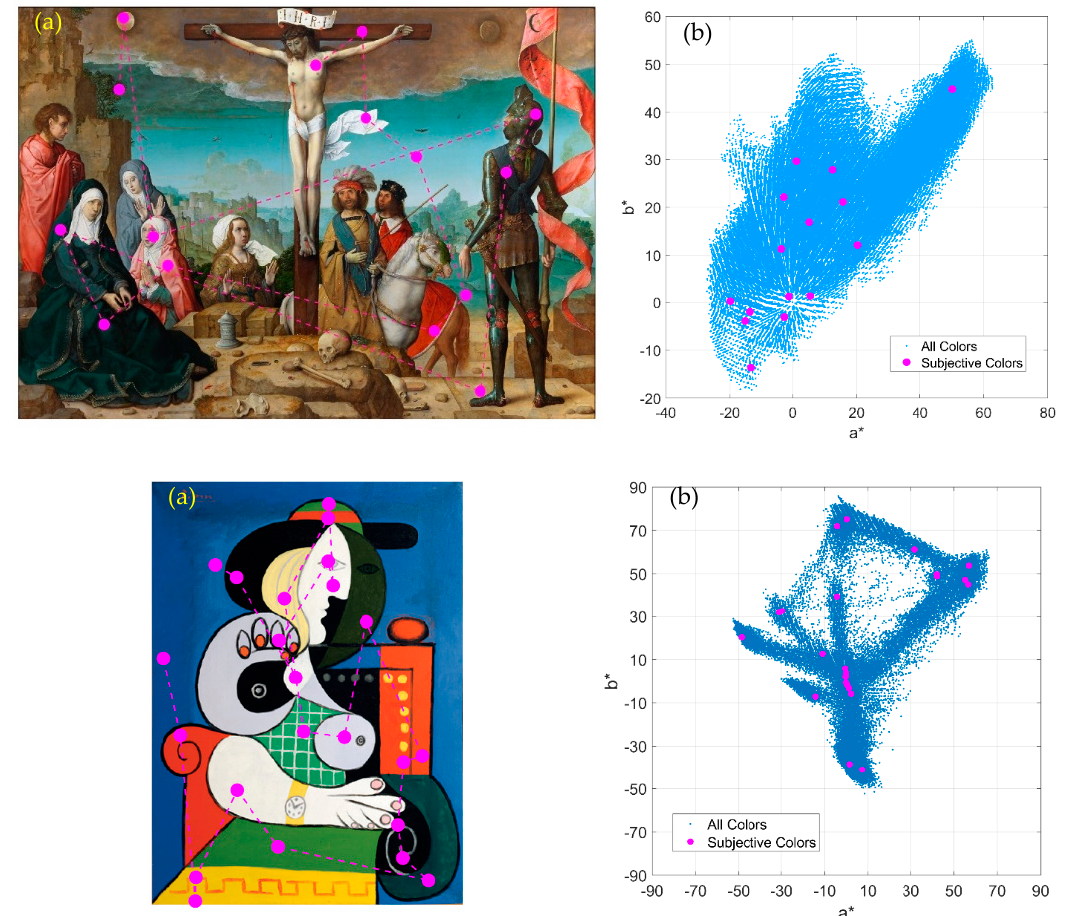
Figure 2. ( a ) Example of the colours selected as relevant colours (magenta circles) for one image from the Prado museum ( The Crucifixion , by Juan de Flandes, 1509–1519) and one example from the Khan database ( Seated woman with wrist watch , by Picasso, 1932). ( b ) CIEa*b* colour coordinates of all the colours within the image and the relevant colours chosen by one observer according to the subjective impression of the corresponding painting.